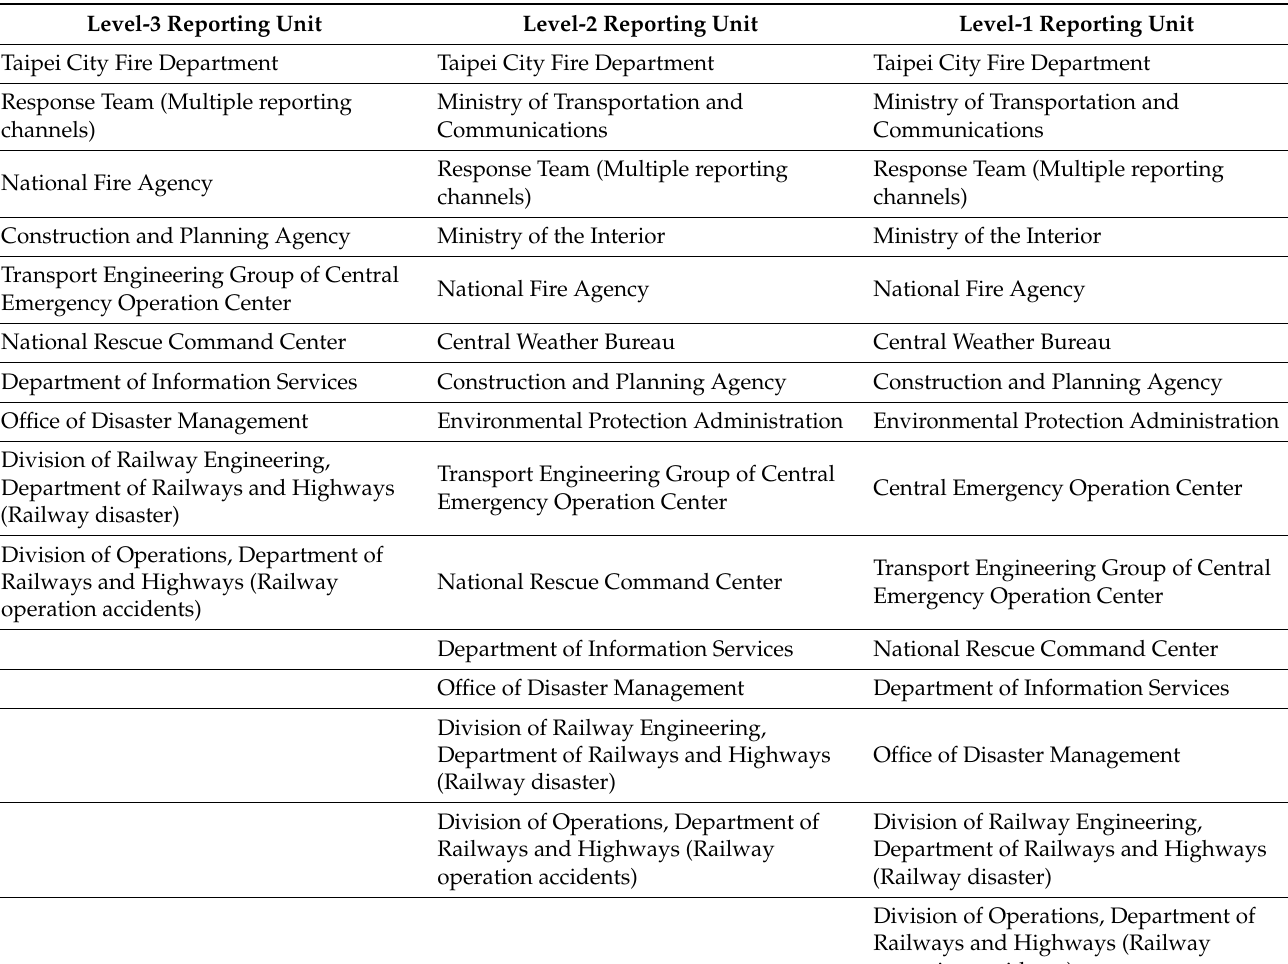
Table 8. Report to the superior units at all levels according to